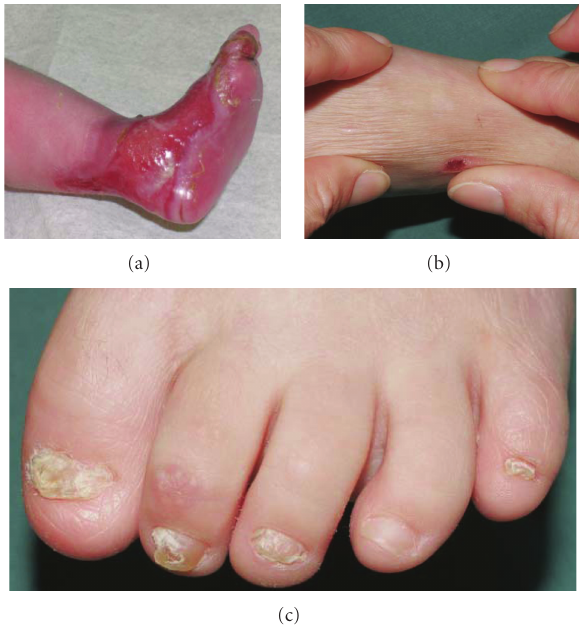
Figure 2: (a) Extensive denuded area enclosing the heel, ankle, joint, and dorsum of the left foot shortly after birth. (b) The same region at the age of 2 years showing an atrophic scar. (c) Dystrophy of toenails.